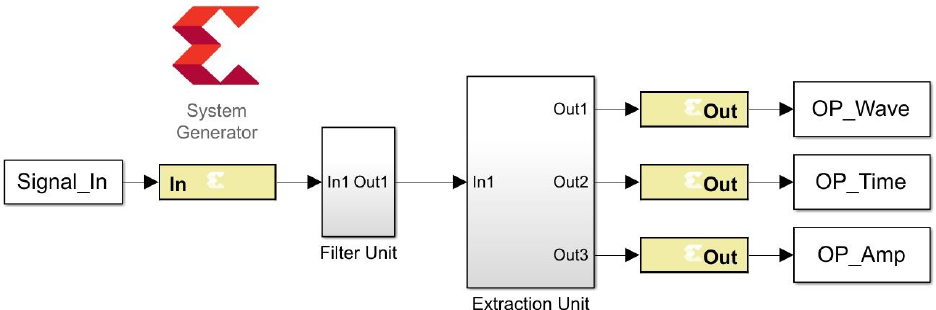
Figure 6. Design of a single-channel unfiltered input system (SCUF) in SysGen.